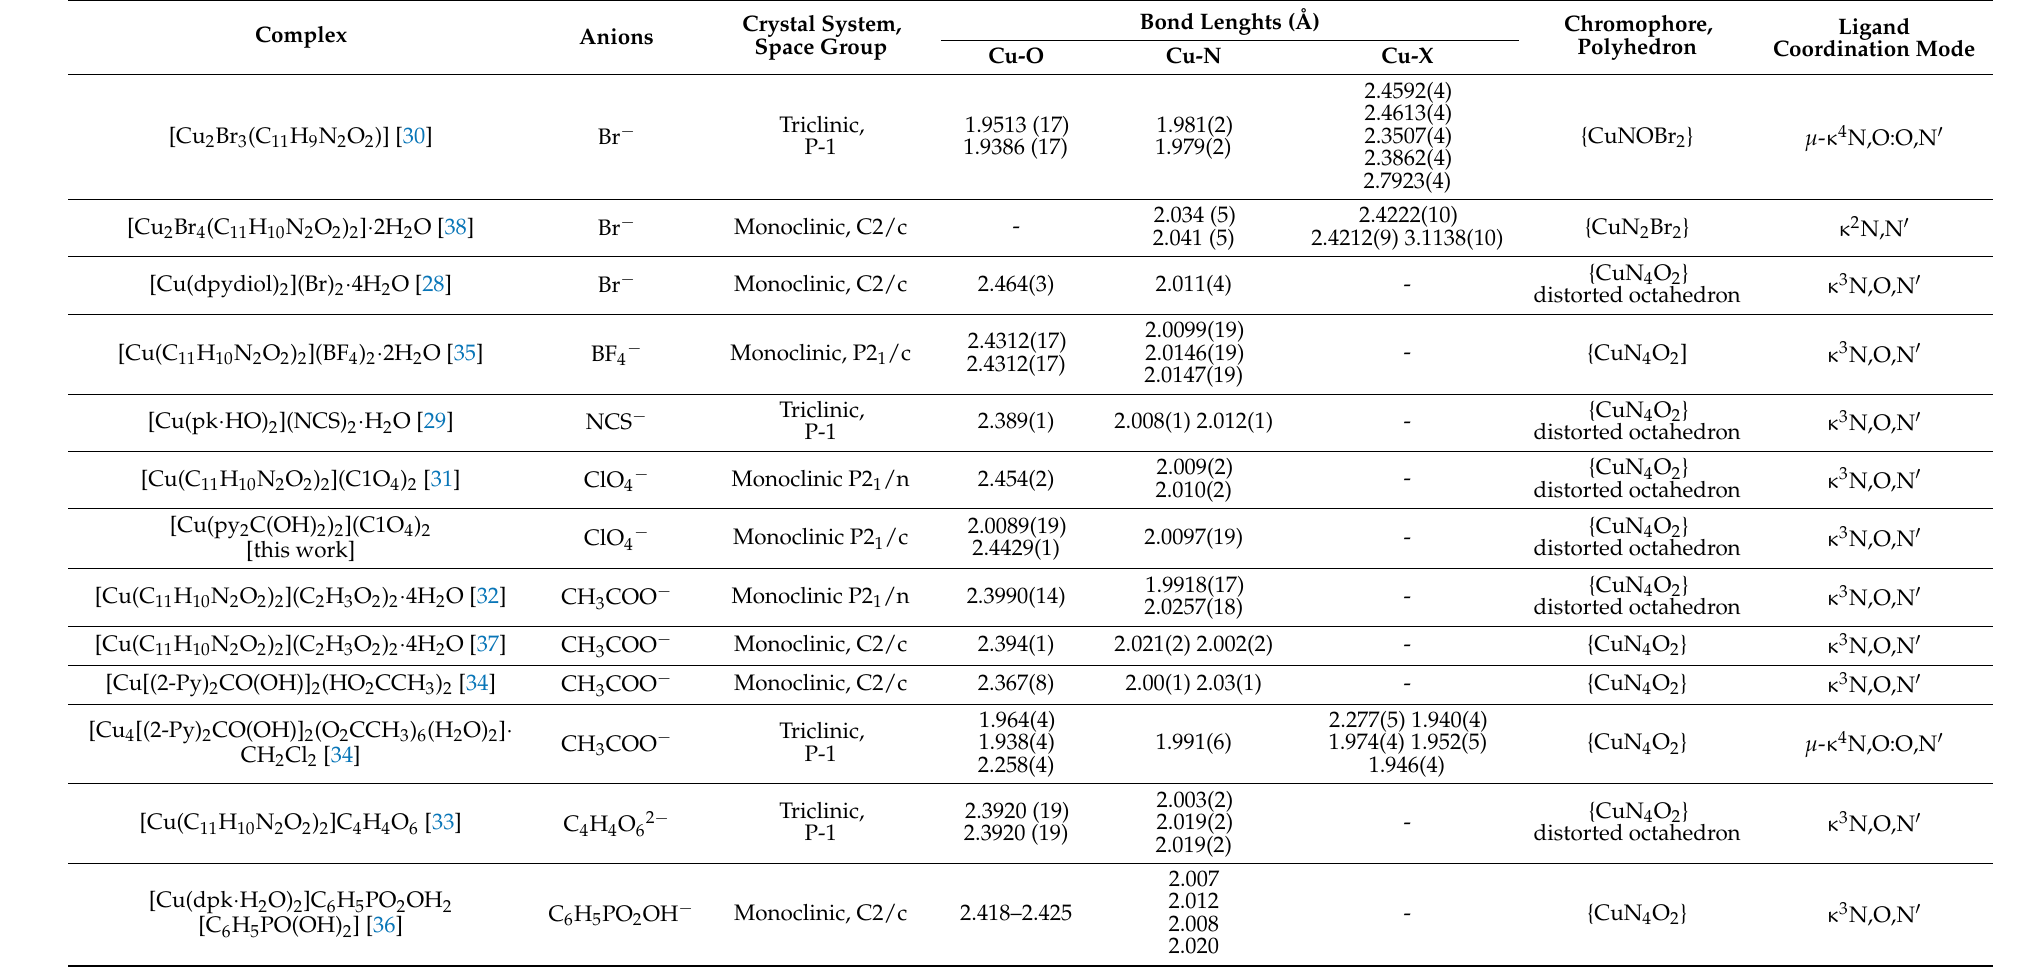
Table 2. Structural features for the Cu(II) complexes with di-(2-pyridyl)methanediol as ligand and different